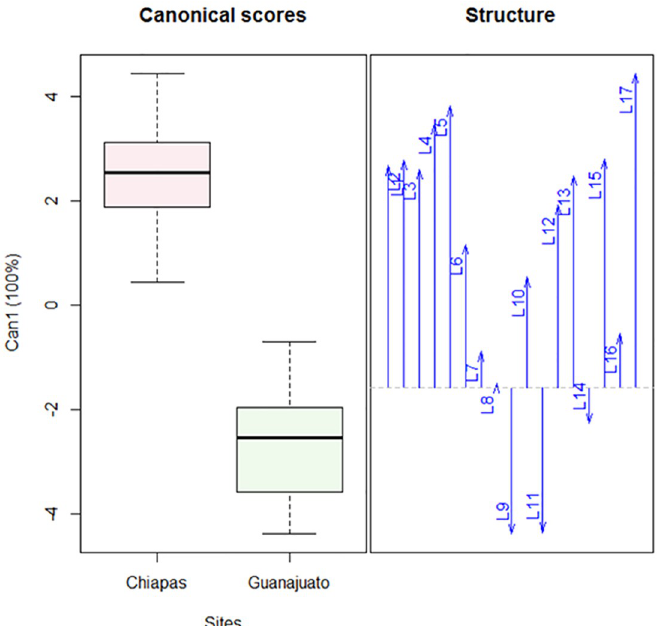
Fig 3. Canonical discriminant analysis of the morphological variables of Polyphagotarsonemus latus (females). The box-and-whisker plot shows a difference between both populations; arrows indicate the correlation: L9, L11 and L14 are negatively correlated and affect the separation between the populations. The key to the abbreviations can be found in Materials and methods (Morphological and biometric study).